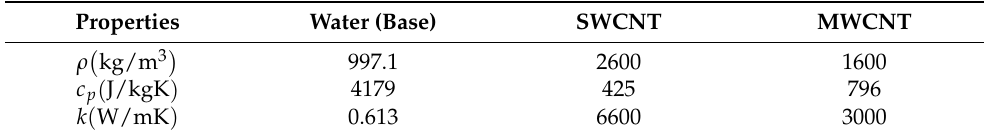
Table 1. Characteristics (thermophysical) of water and